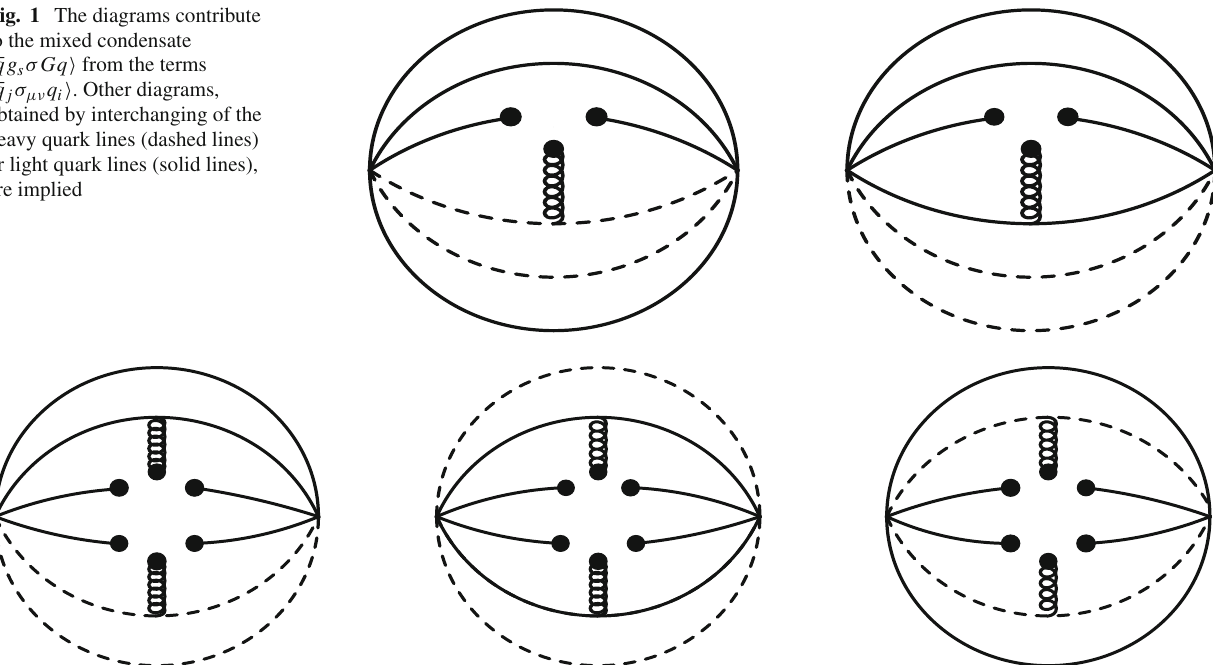
Fig. 1 The diagrams contribute to the mixed condensate (cid:6)¯ qg σ Gq (cid:7) from the terms s (cid:6)¯ q σ μν q (cid:7) . Other diagrams, j i obtained by interchanging of the heavy quark lines (dashed lines) or light quark lines (solid lines), are implied